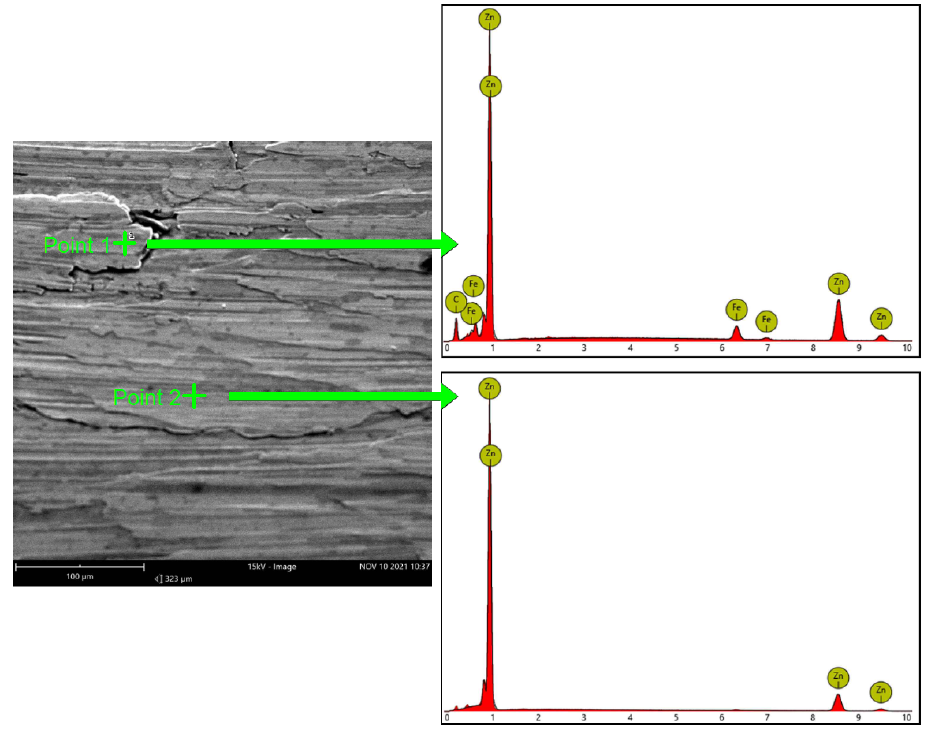
Figure 10. Results of energy-dispersive X-ray spectroscopy (EDS) analysis for the front (inner) sur-